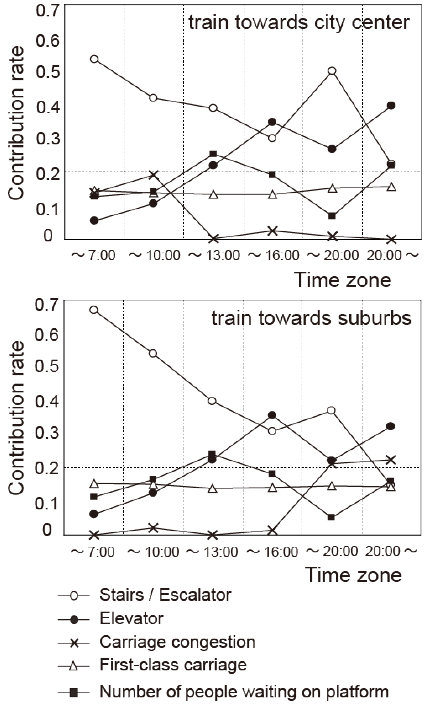
Figure 5 . Mean contribution